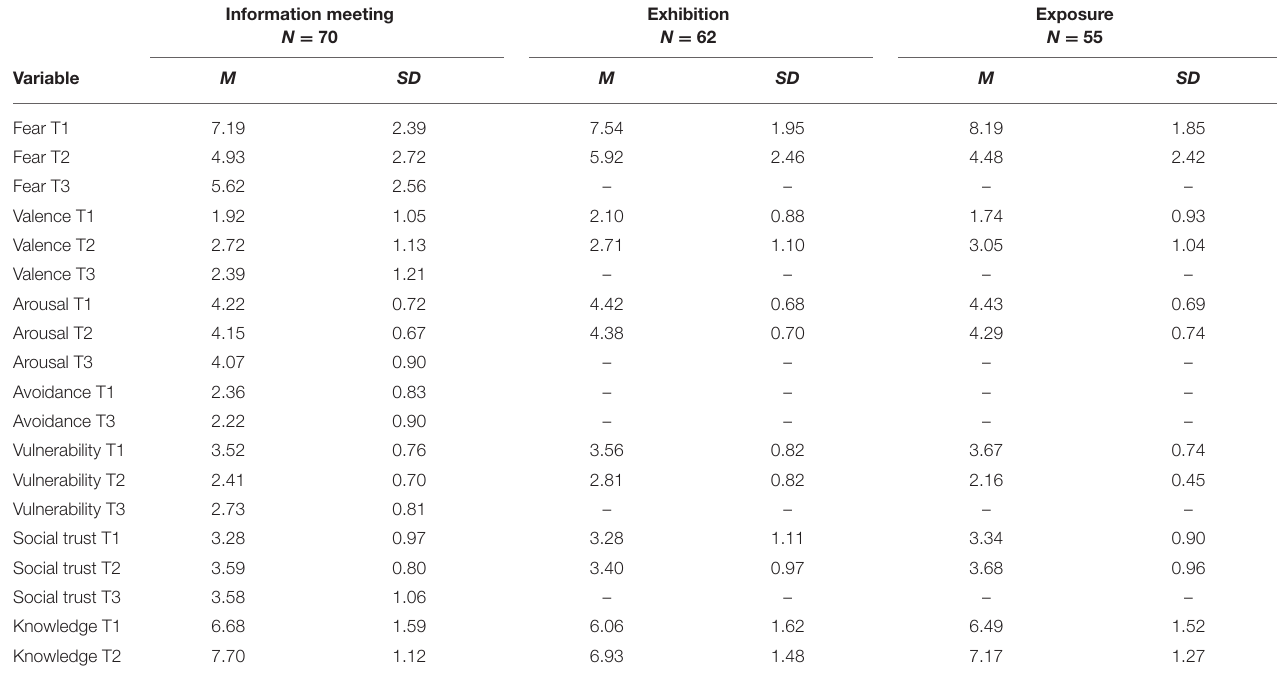
TABLE 2 | Mean values and standard deviations at T1, T2, and T3 for the three